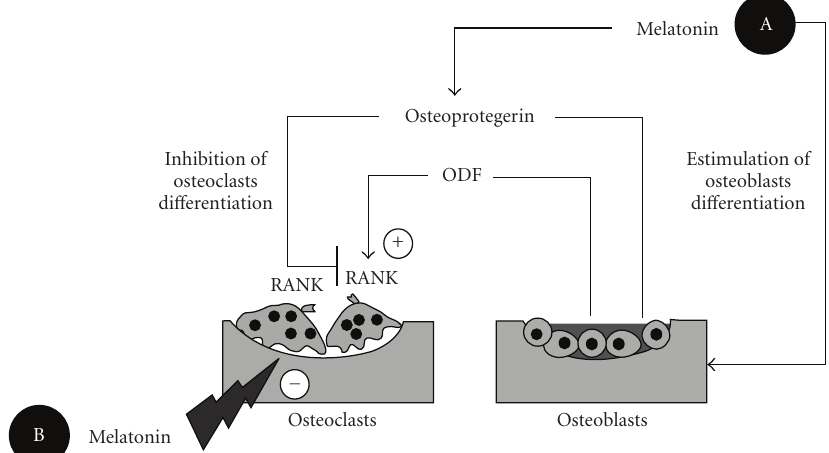
Figure 1: E ff ects of melatonin on bone metabolism. (a) Melatonin promotes the osteoblast proliferation and the synthesis osteoprotegerin, which inhibits the di ff erentiation of osteoclasts by preventing the binding of ODF (osteoclast di ff erentiation factor) to RANK on the di ff erentiating osteoclasts. (b) Melatonin through its free radical scavenging properties impairs osteoclast activity on bone. Based on Cardinali et al.